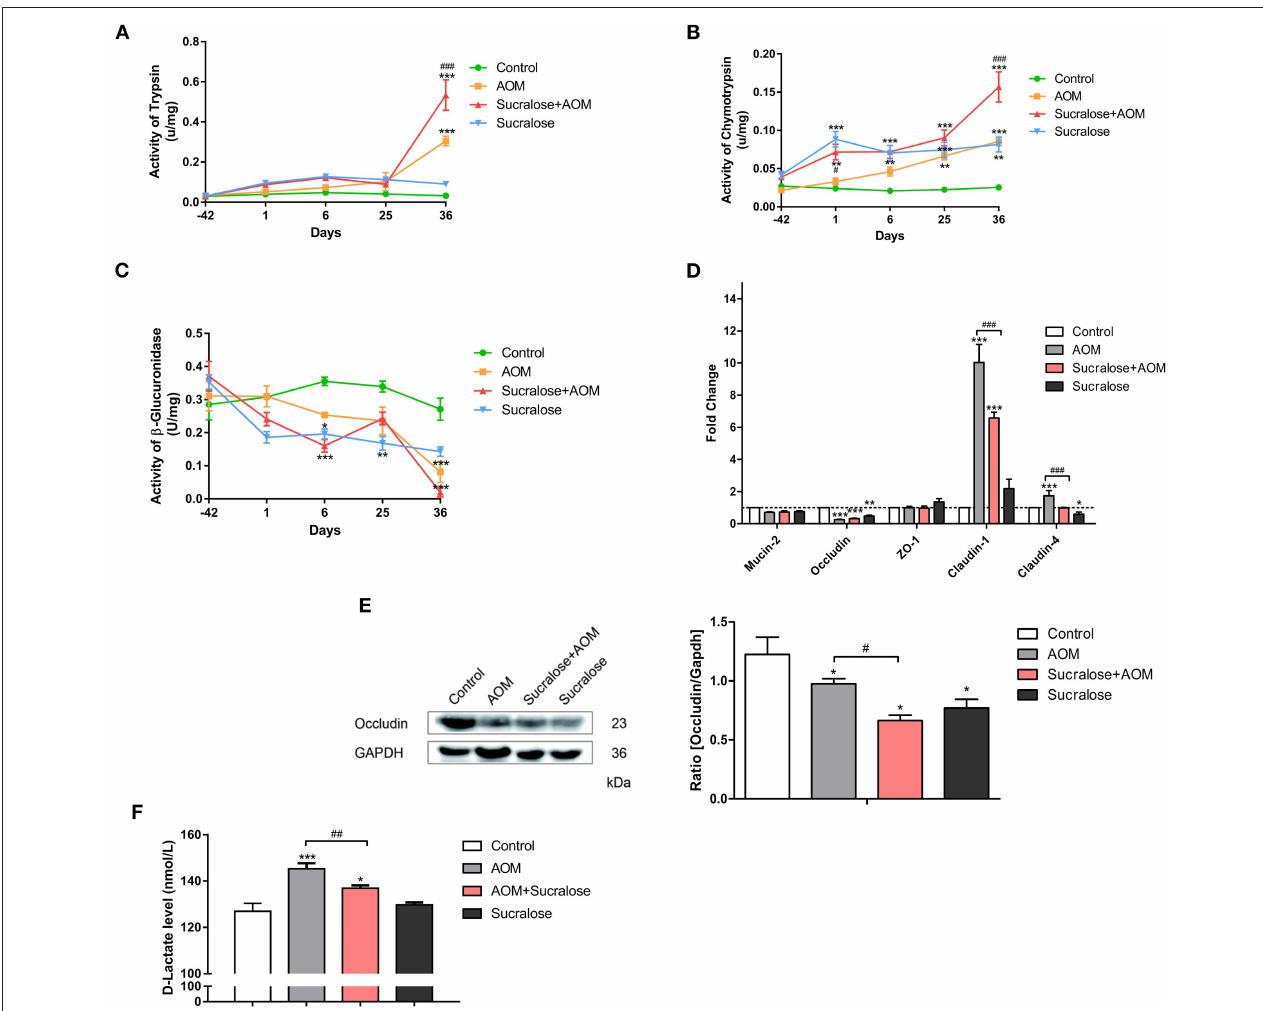
FIGURE 2 | Sucralose aggravates damage to the colonic mucosal barrier in AOM/DSS colon cancer mice. (A) Trypsin activity in feces, (B) chymotrypsin activity in feces, (C) β -glucuronidase activity in feces, (D) changes in mucosal barrier molecule mRNA levels, (E) occluding (tight junction protein) expression, and (F) serum D-Lac levels. Compared with the control group: * P < 0.05, ** P < 0.01, *** P < 0.001; compared with the AOM group: # P < 0.05, ## P < 0.01, ### P < 0.001, n = 8.